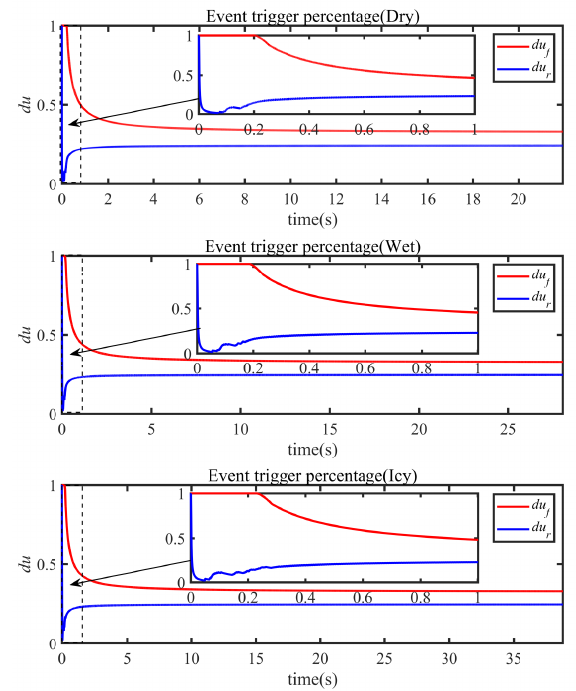
Figure 10. Simulation results for the estimation of matched and unmatched perturbations, where (a) and (b) represent estimations of d 1 and d 2 , respectively.